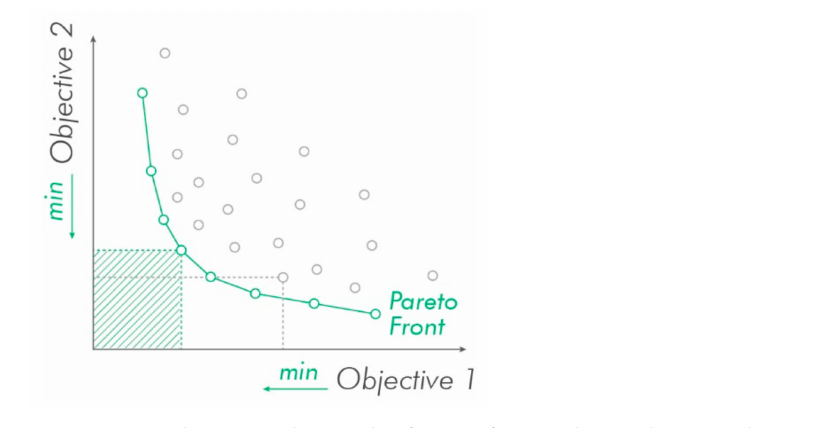
Figure 3. Two-dimensional example of Pareto front with two objectives that we want to